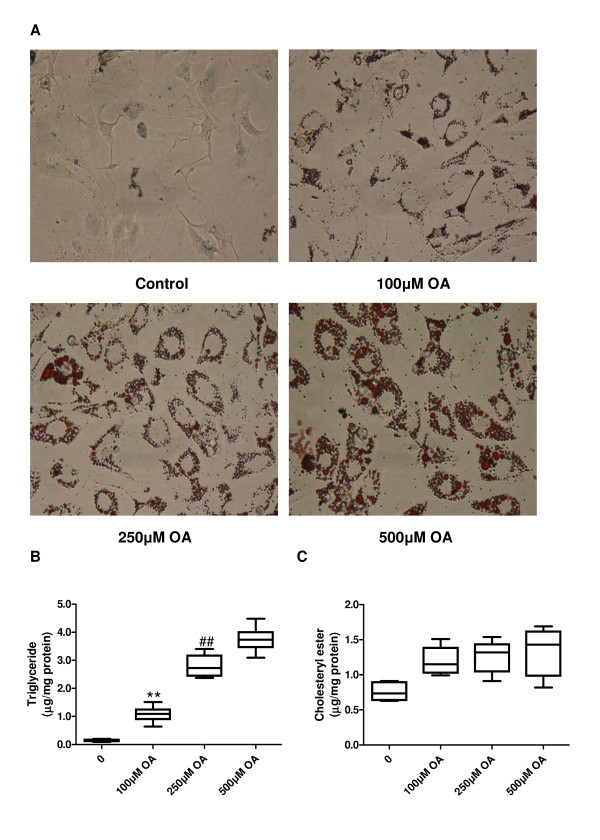
Vascular smooth muscle foam cell formation is induced by OA treatment. (A) Cellular lipid accumulation in rat aortic SMCs after incubation for 48 hours with indicated concentrations of OA. Magnification ×400. Triglyceride (B) and cholesterol ester (C) levels normalized to cellular protein content in rat aortic SMCs. Data are expressed as mean ± SEM. ** p < 0.01 compared with the control group, ## p < 0.01 compared with the cells treated with 100 μmol/L of OA. OA, oleic acid; SMCs, smooth muscle cells.